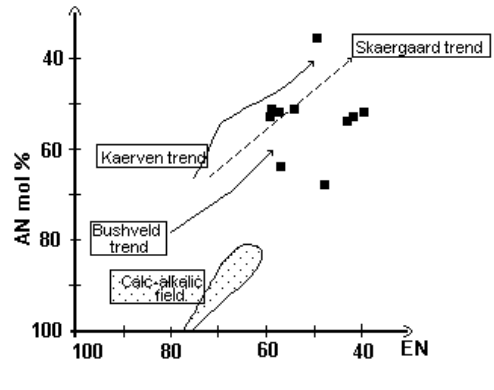
Fig. 17–CoexistingplagioclaseandOPXcompositionsfromthe VarzeaAlegre pluton, contrasted with trends from other tholeiitic sequences (Kaerven, East Greenland ; Bushveld and Skaergaard; modified after Burns